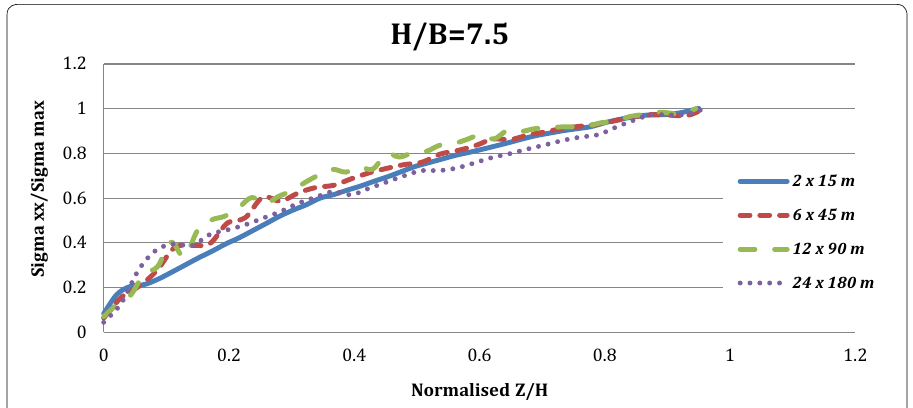
Fig. 13 Comparison of stope backfill with H/B